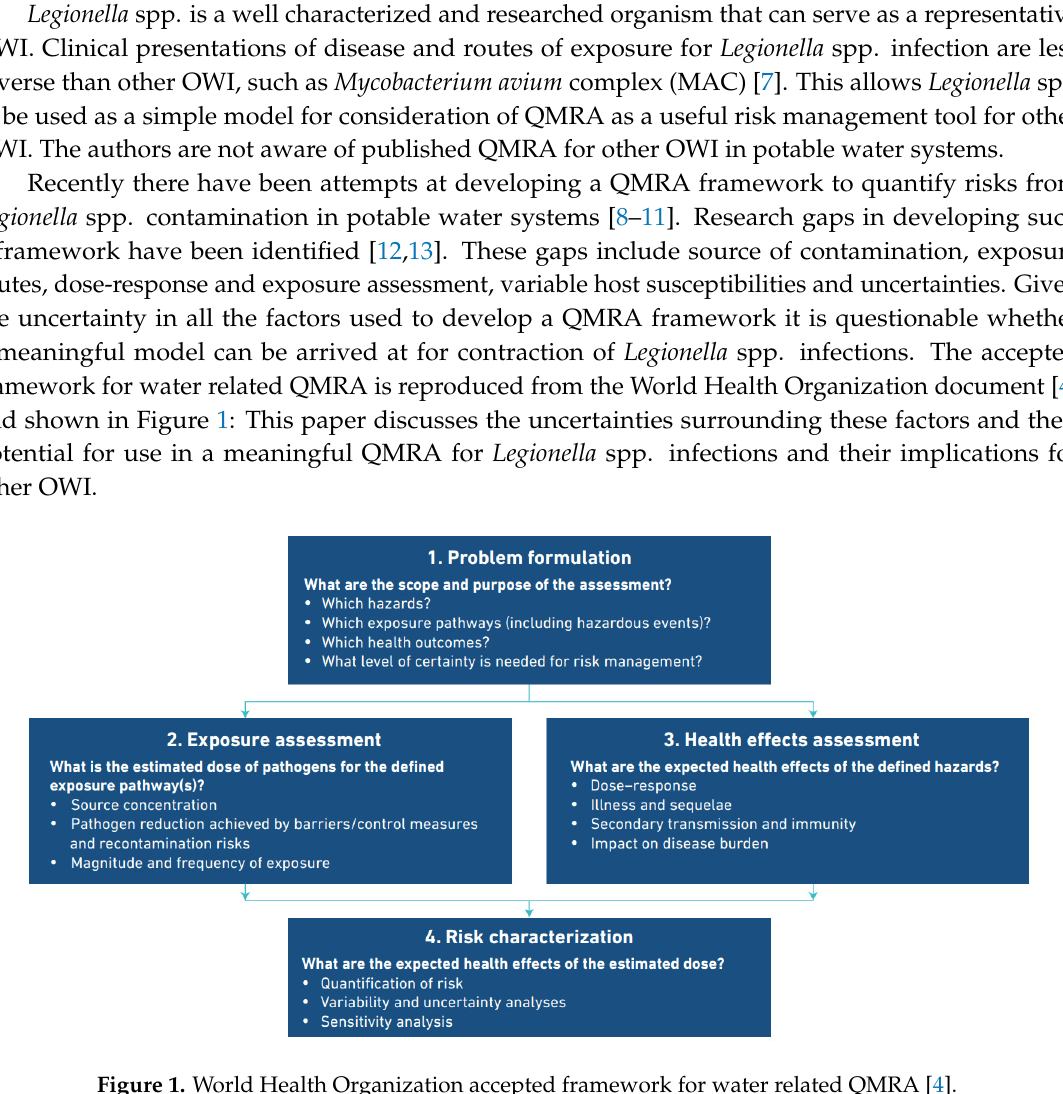
Figure 1. World Health Organization accepted framework for water related QMRA [4].